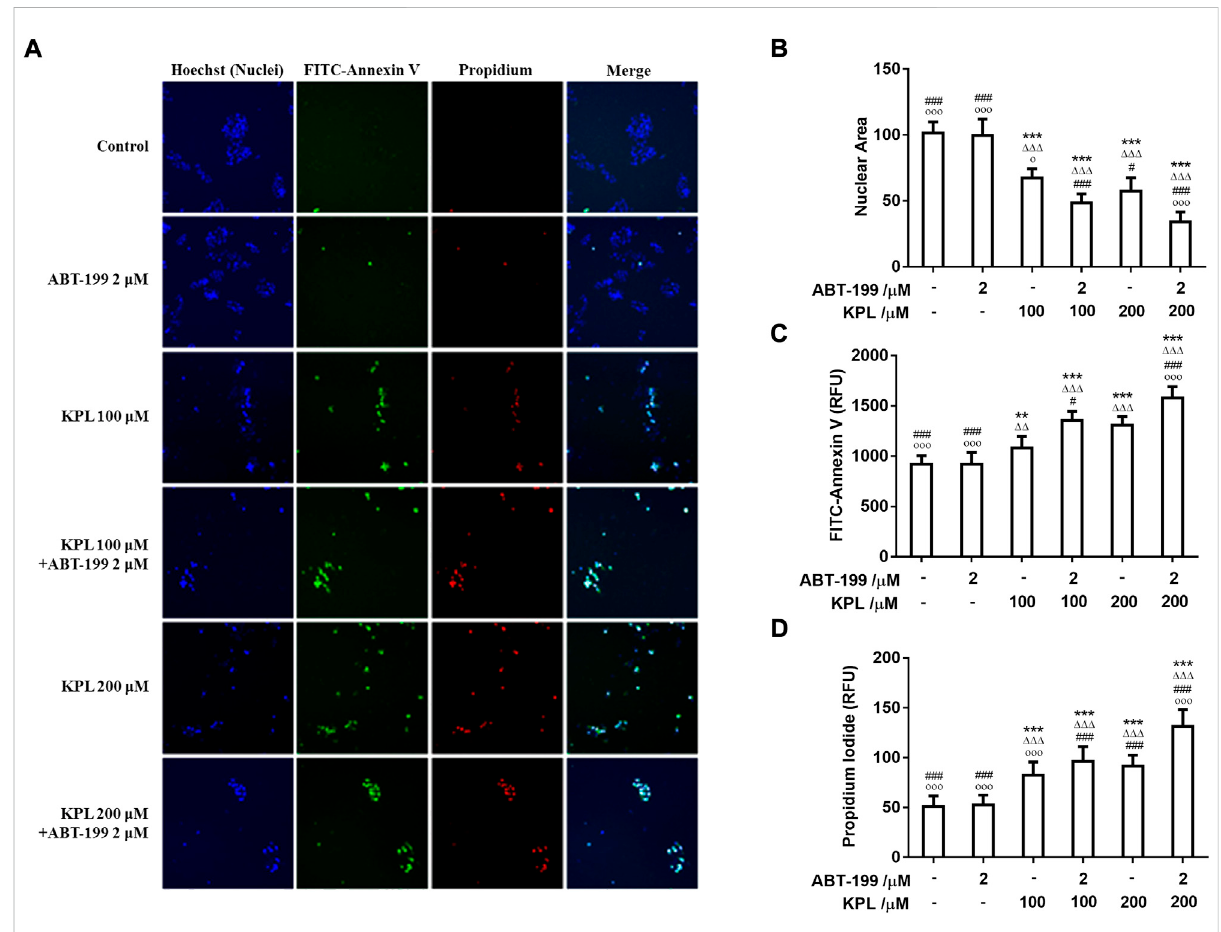
The effect of KPL combined with ABT-199 on apoptosis of HepG2 cells. (A) Representative images of cell apoptosis in various groups. Different concentrationsofKPLwithorwithout2 μ MABT-199weretreatedonHepG2cellsfor24 h,andthentheapoptosiswasdetectedbyHoechst33342/ FITC-AnnexinV/PItriplestaining.TheimageswerecollectedbyanArrayscanVT1HCSreader.Mergedimageswerethecompositionofimagesofthe same fi eld from three different channels. (B) The effects of various concentrations of KPL with or without ABT-199 on the nuclear area. (C) FluorescenceintensityofFITCAnnexinVstaininginHepG2cellstreatedbyvariousconcentrationsofKPLwithorwithoutABT-199. (D) Fluorescence intensity of PI staining in HepG2 cells treated by various concentrations of KPL with or without ABT-199. Values are means ± SD ( n = 12). ** p < 0.01, *** p < 0.001 versus negative control group; ΔΔ p < 0.01, ΔΔΔ p < 0.001 versus ABT-199 alone group; # p < 0.05, ### p < 0.001 versus KPL 100 μ M